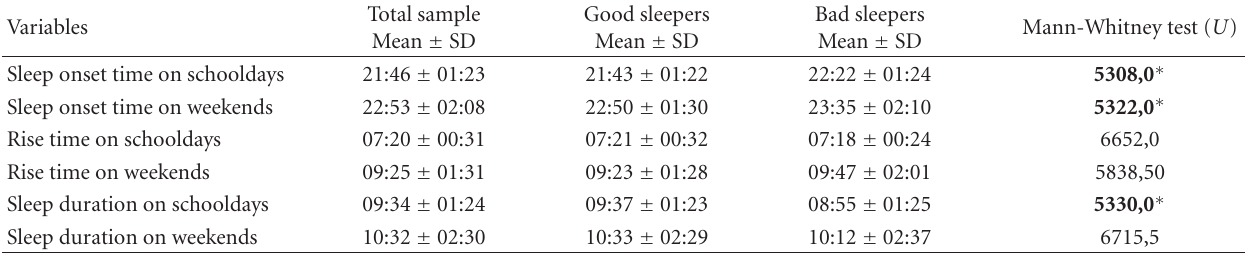
Table 2: Descriptive data on sleep habits and their comparison between good and bad sleepers.